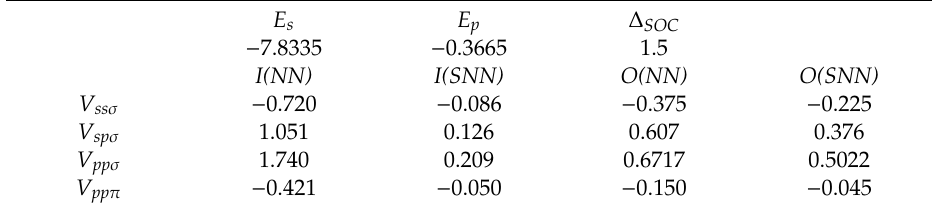
Table 1. Tight-binding parameters for double-bilayer bismuthene: E s and E p are on-site energies of the s and p orbitals, respectively, ∆ SOC is spin-orbit splitting and the other factors are Slater–Koster type integrals. I(NN) and I(SNN) stand for the intra-bilayer nearest neighbors and second-nearest neighbors, respectively, while O(NN) and O(SNN) are the inter-bilayer nearest neighbors and second-nearest neighbors, respectively. All energies are in the unit of